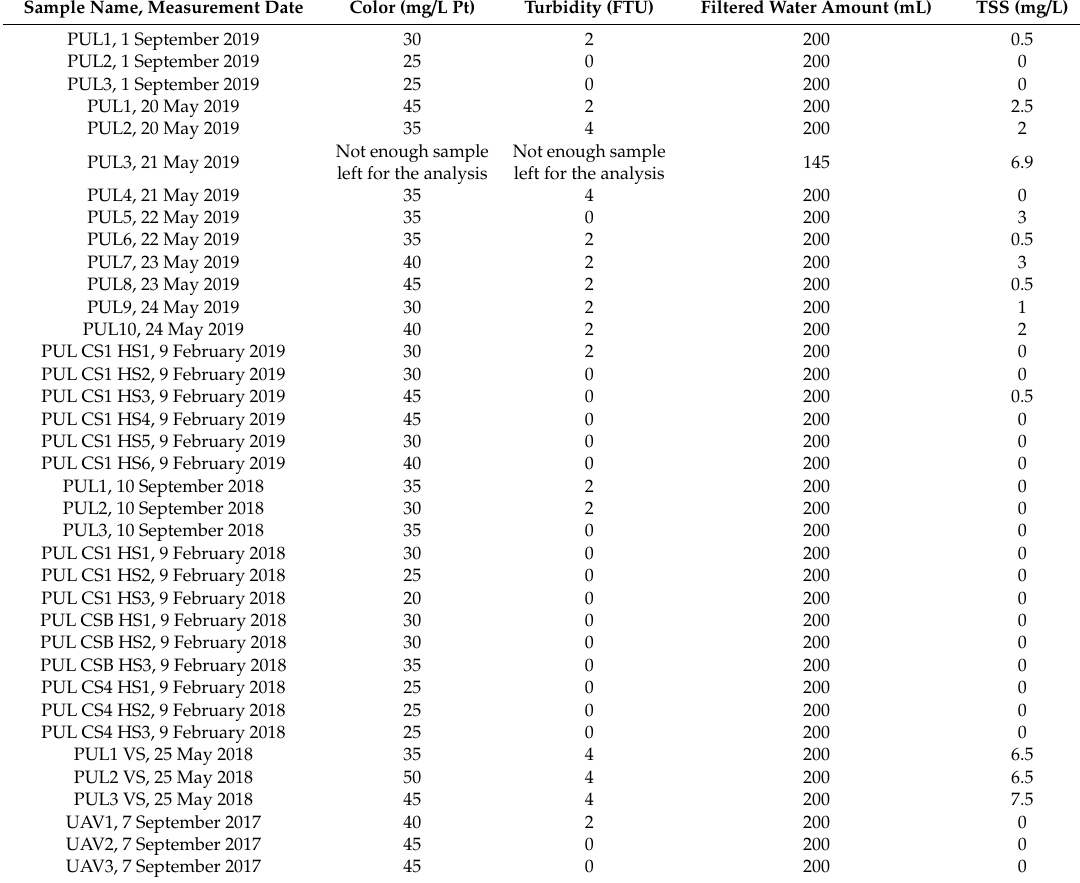
Table 5. The total suspended solids (TSS) transport, and the water color and turbidity of the Pulmanki River between Autumn 2017–Autumn